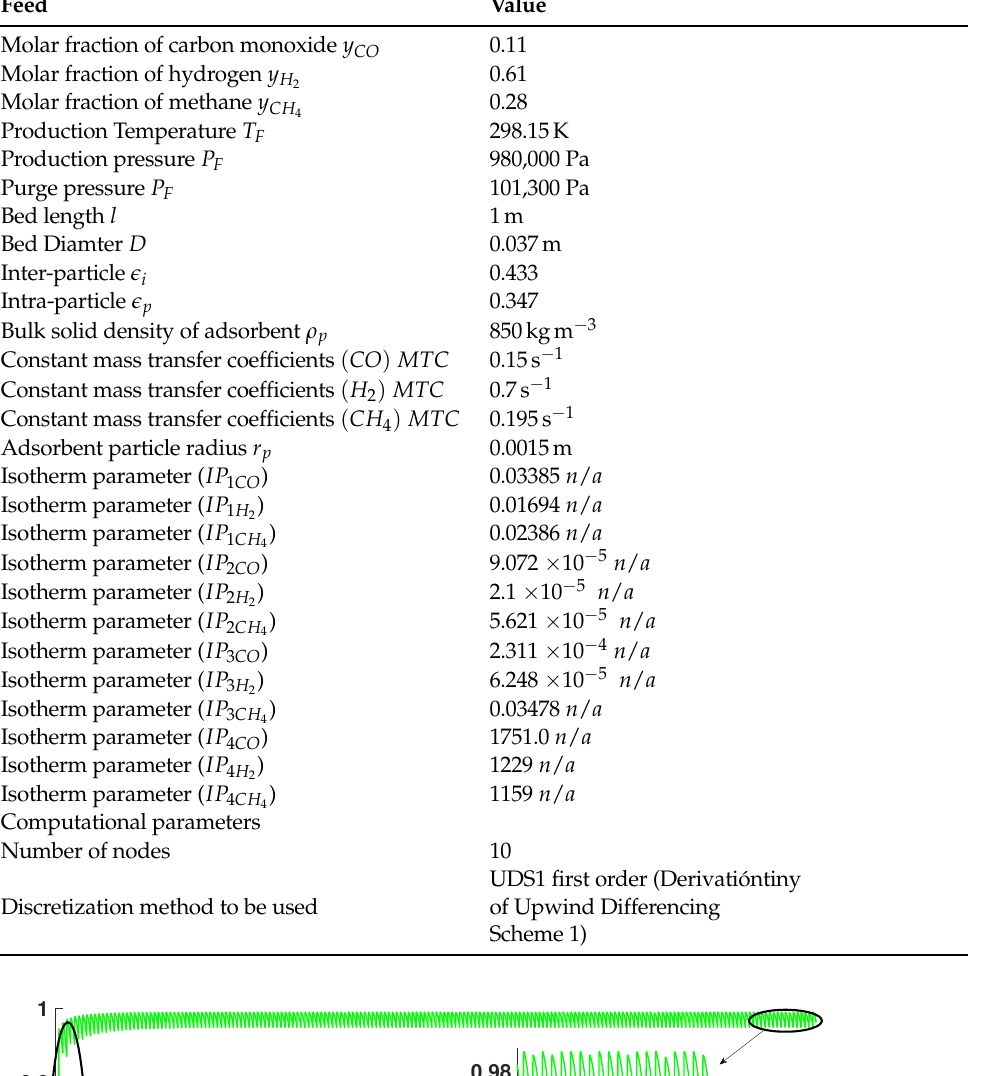
Table 3. Parameter values used for the PSA process.